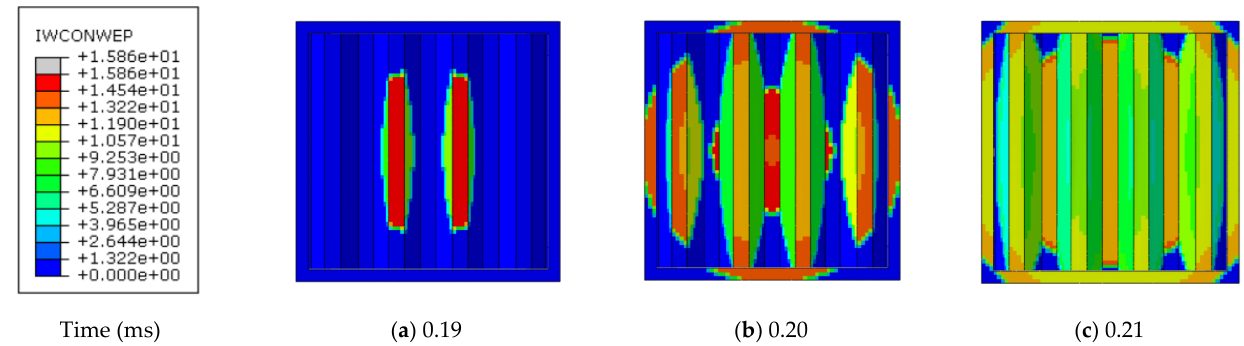
Figure 5. Distribution and values of ConWep peak reflected overpressure on the trapezoidal-core sandwich panel, when subjected to blast intensity BI-5. ( a ) at 0.19 ms; ( b ) at 0.20 ms; ( c ) at 0.21 ms.